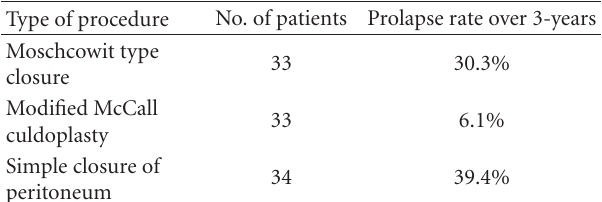
Table 1: RCT involving 100 patients comparing procedures used at the time of hysterectomy to prevent enterocoele